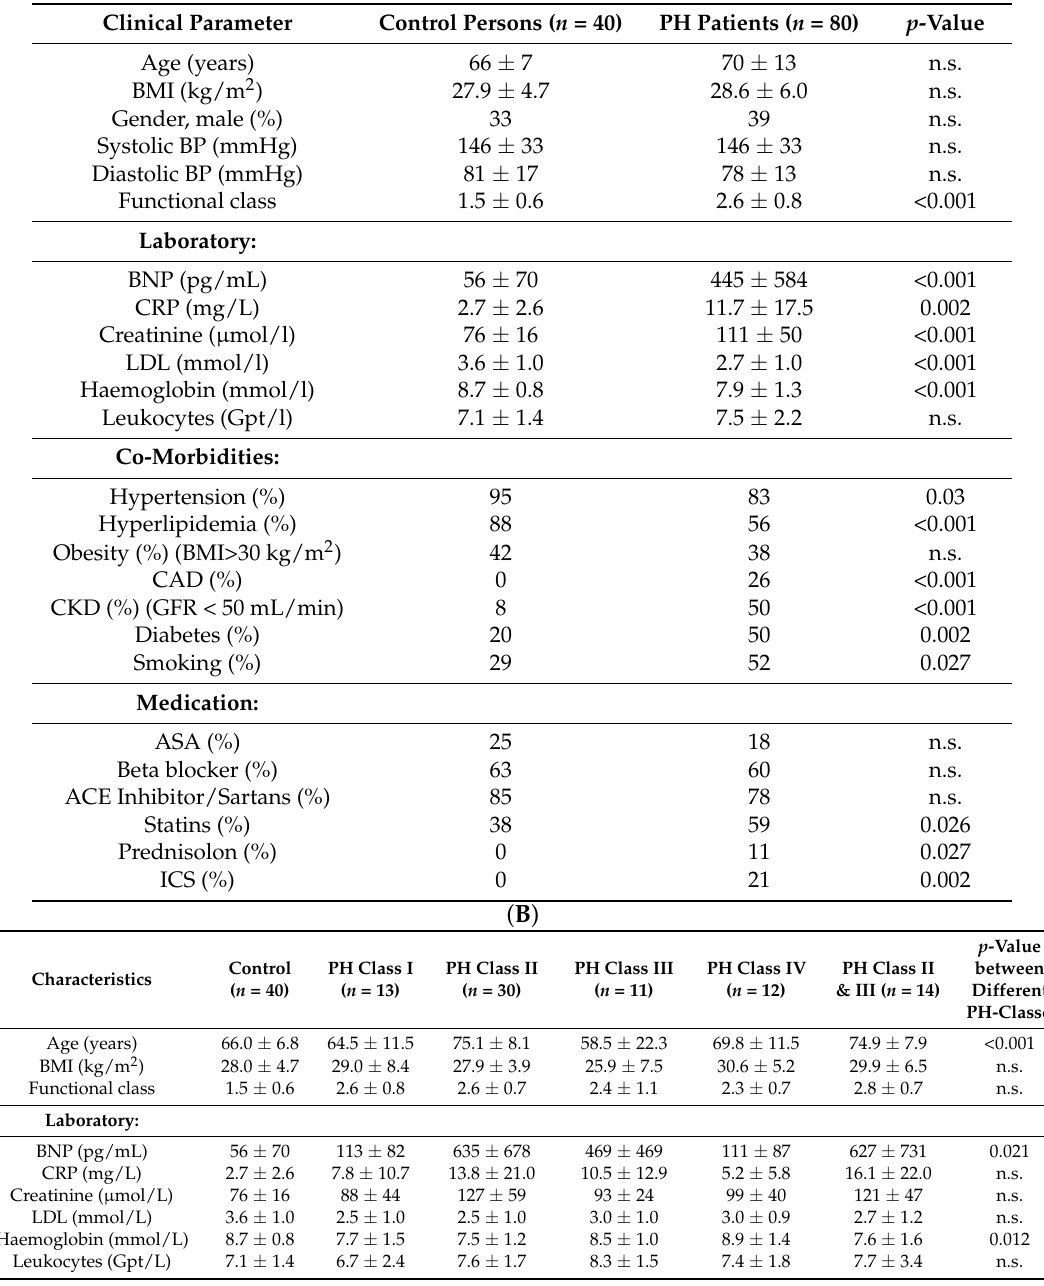
Table 1. Clinical data: Cardiovascular risk factors and medication of the study groups. In ( A ) presented for patients with pulmonary hypertension irrespective the etiology and control patients, in ( B ) presented for patients with pulmonary hypertension that are subdivided according to the etiology and control